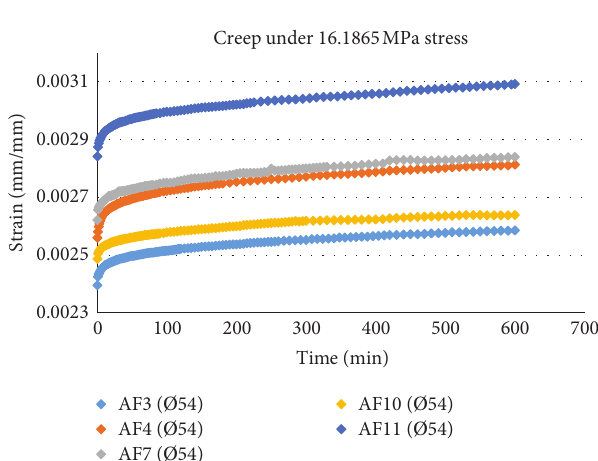
Figure 15: Network of 10-hour creep curves of Ø54 specimens under a load of 16.1865MPa.